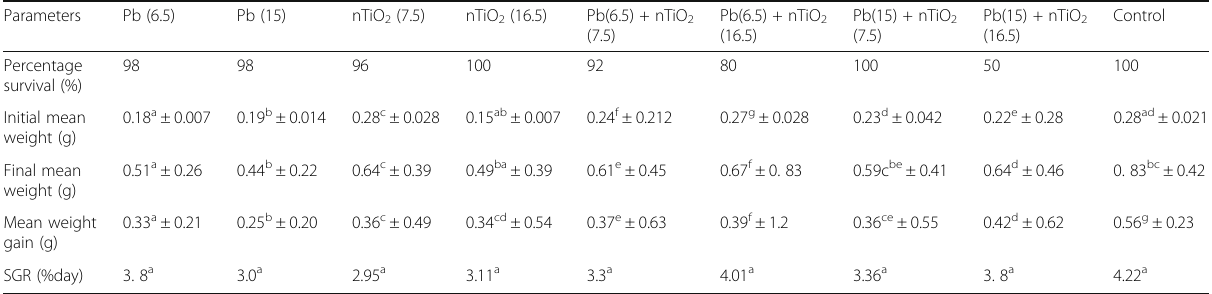
Table 1 Growth response and survival of C . gariepinus fries fed with contaminated zooplankton of Pb and nTiO 2 Parameters